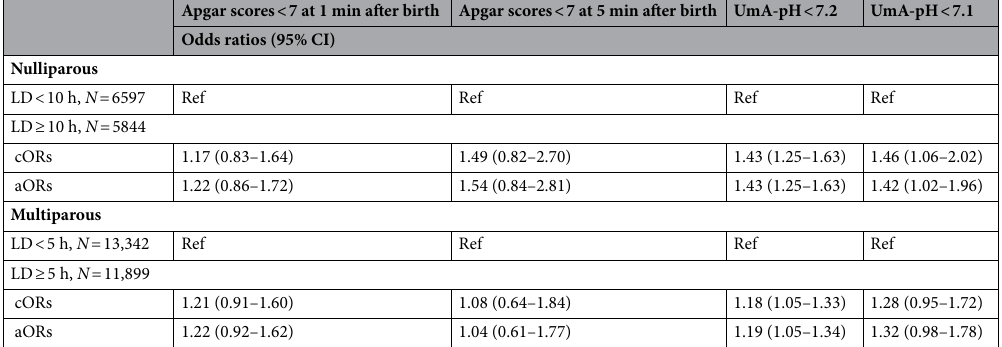
Apgar scores < 7 at 1 min after birth Apgar scores < 7 at 5 min after birth UmA-pH < 7.2 UmA-pH <